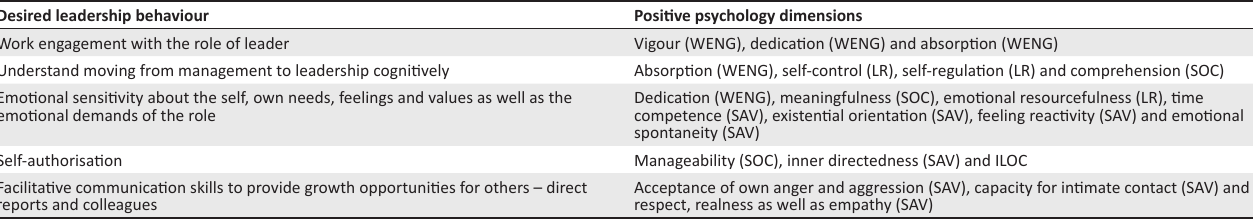
WENG, work engagement; LR, learned resourcefulness; SOC, sense of coherence; SAV, self-actualisation values; ILOC, internal locus of